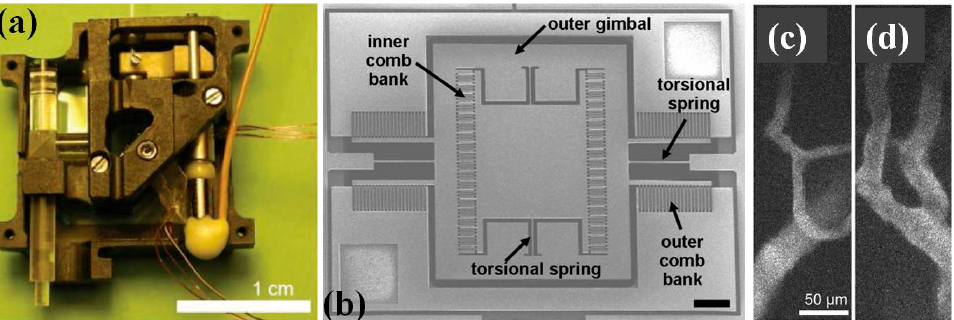
Figure 16. MEMS based two-photon microscope. ( a ) Photograph of the assembled microscope, electrical lines control the MEMS scanner and focusing micromotor. ( b ) Scanning electron micrograph of the two-dimensional MEMS scanner for en-face two-photon imaging, 750 µ m × 750 µ m scanning mirror in a 3.2 mm × 3.0 mm die, six banks of vertical comb actuators drive the mirror, which has a gimbal design, scale bars are 250 µ m. ( c , d ) Images of neocortical capillaries, averaged over eight frames acquired over 2 s at 4 Hz (Reproduced with permission from OSA [99]).